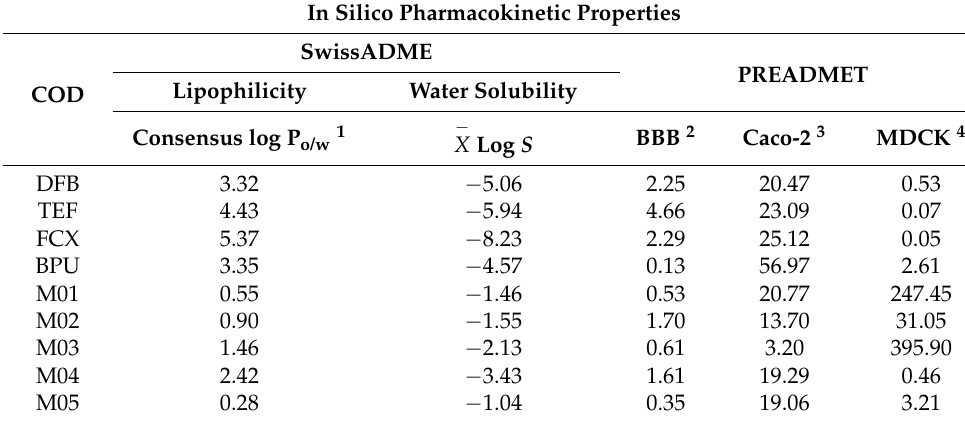
Table 3. Pharmacokinetic properties of selected